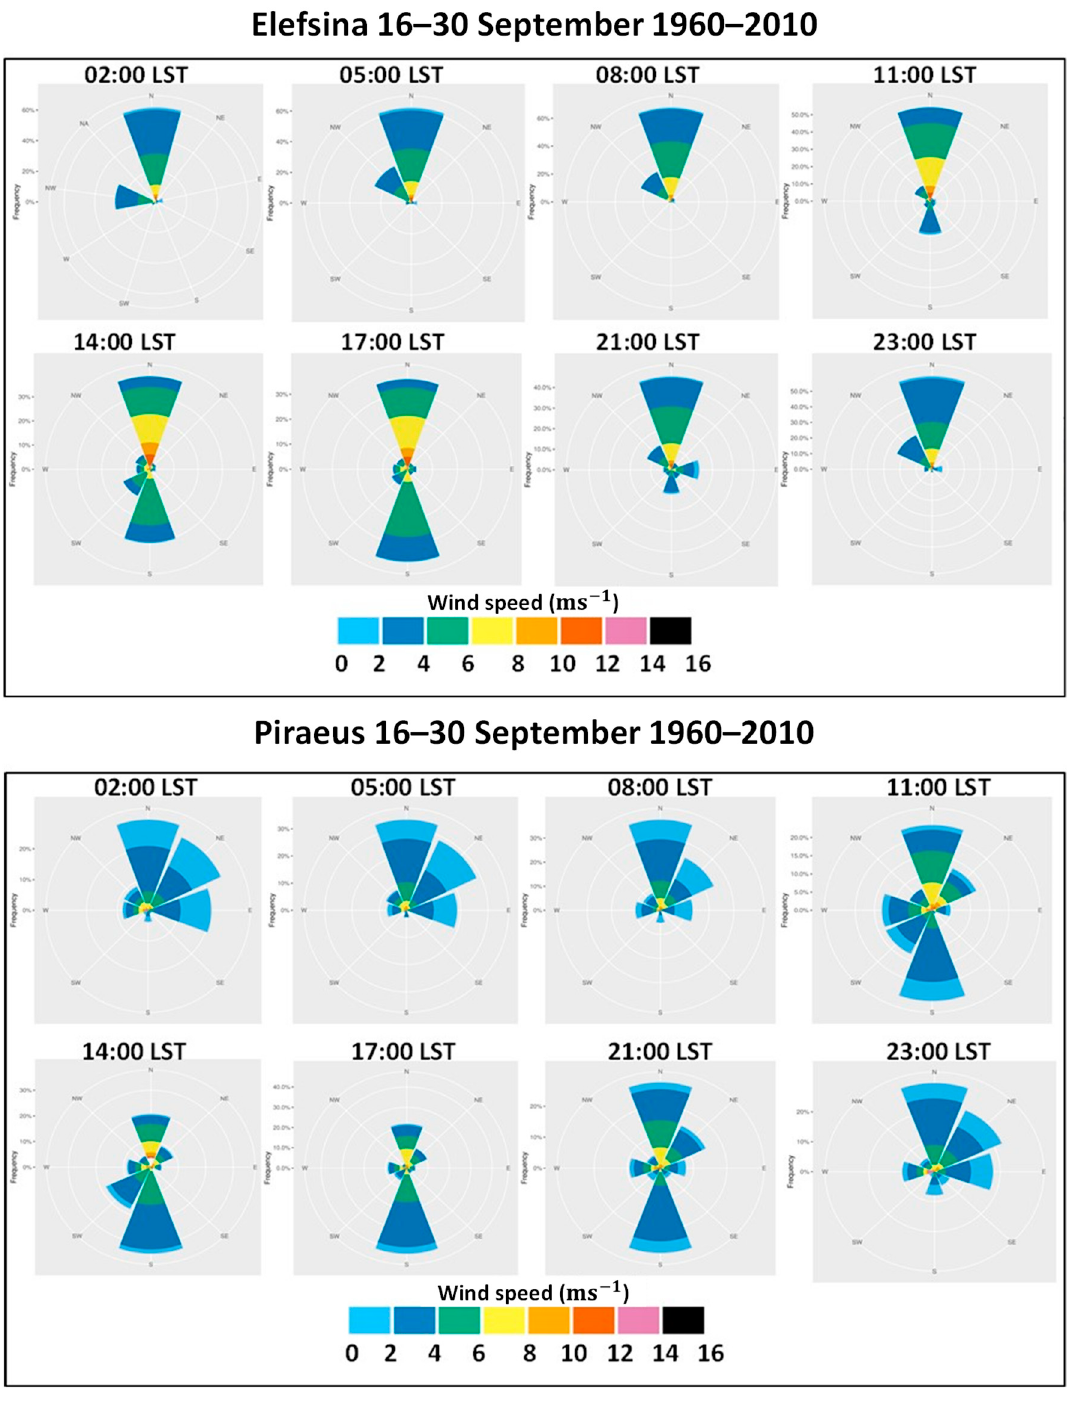
Figure 4. ( top ) Elefsina (38.04° N, 23.54° E) during 1960–2010 and ( bottom ) Piraeus (37.93° N, 23.63° E) during 1960–2010. Elefsina and Piraeus measurements are available at 3-h intervals.